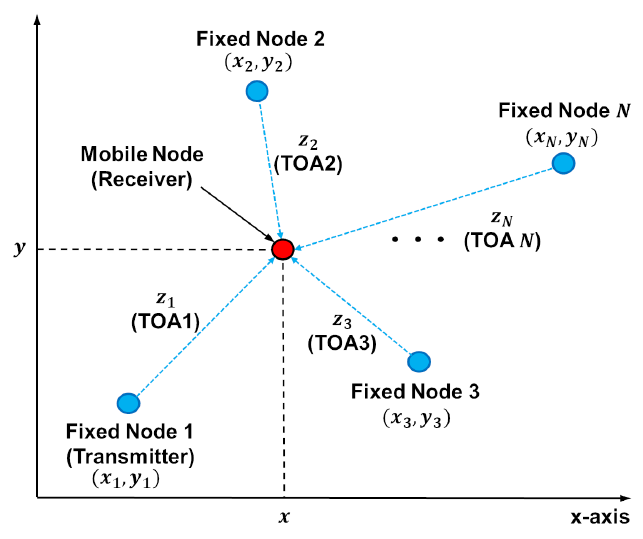
Figure 1. Indoor localization